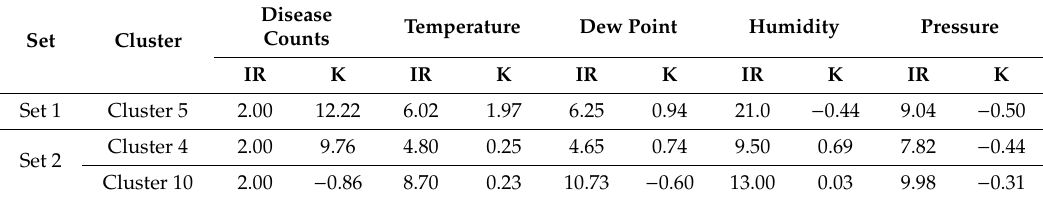
Table 3. Clustering density and homogeneity for selected clusters with high salmonellosis counts. Disease Counts Set Cluster